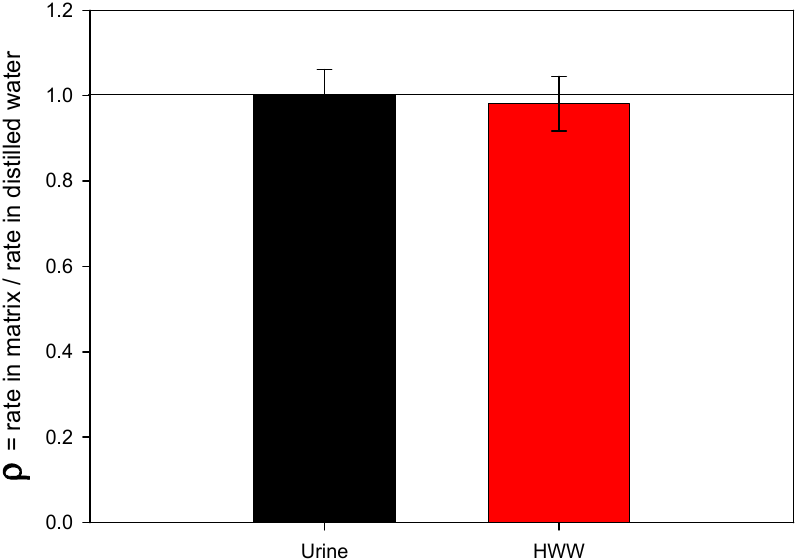
Figure 6. Selectivity of LEV degradation in synthetic urine and simulated hospital wastewater (HWW). Experimental conditions: [LEV] = 13.8 µM, [CdS] = 0.5 g L − 1 , UVA intensity = 40 W m − 2 , and initial pH = 5.3. Table 3. Composition of the simulated hospital wastewater (HWW) 1 . Compound